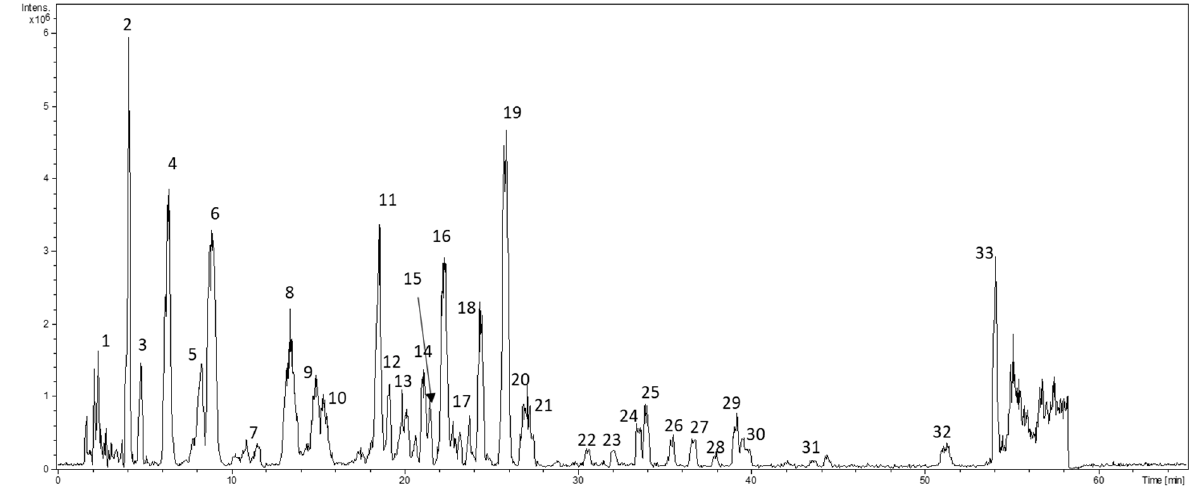
Figure 1. LC-MS base peak chromatogram of Lavandula angustifolia hydroalcoholic extract.